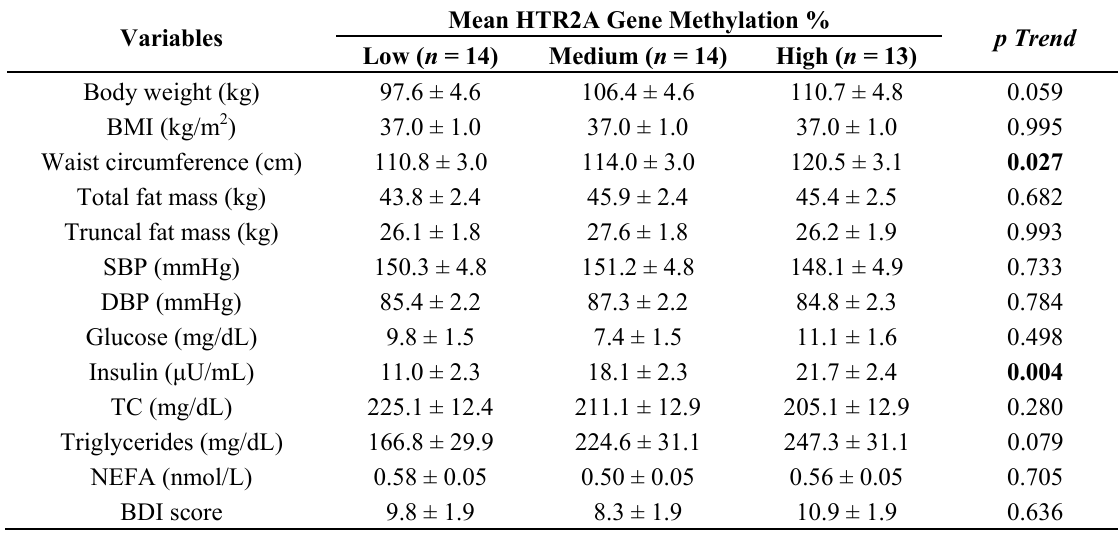
Table 2. Anthropometric, biochemical and psychological characteristics of the whole-study sample stratified by tertiles of mean HTR2A methylation levels at